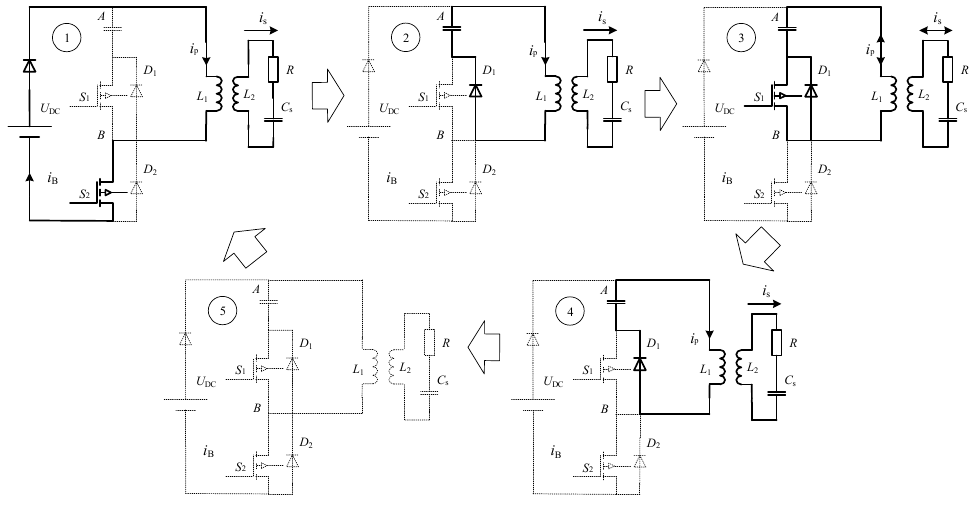
Figure 6. State transitions of the IIEIFR converter.